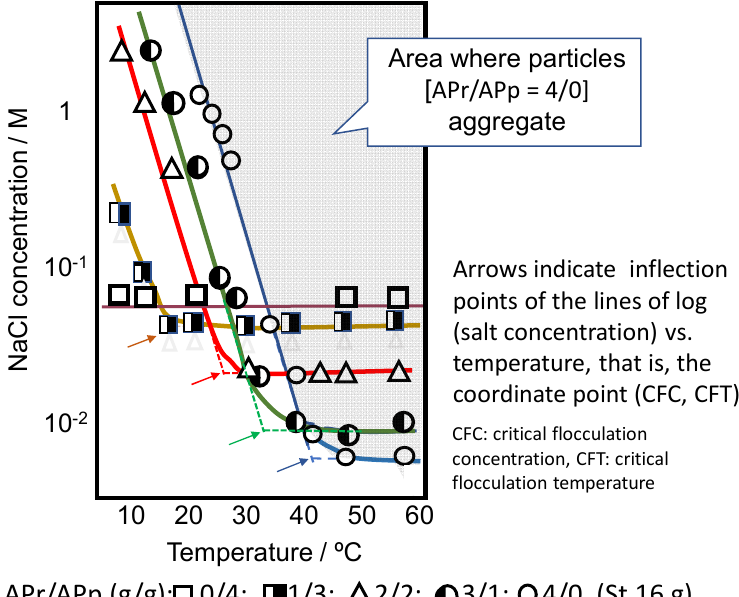
Figure 9. Dependence of stability of PSt-core–APr / APp-shell particles on temperature and NaCl concentration.